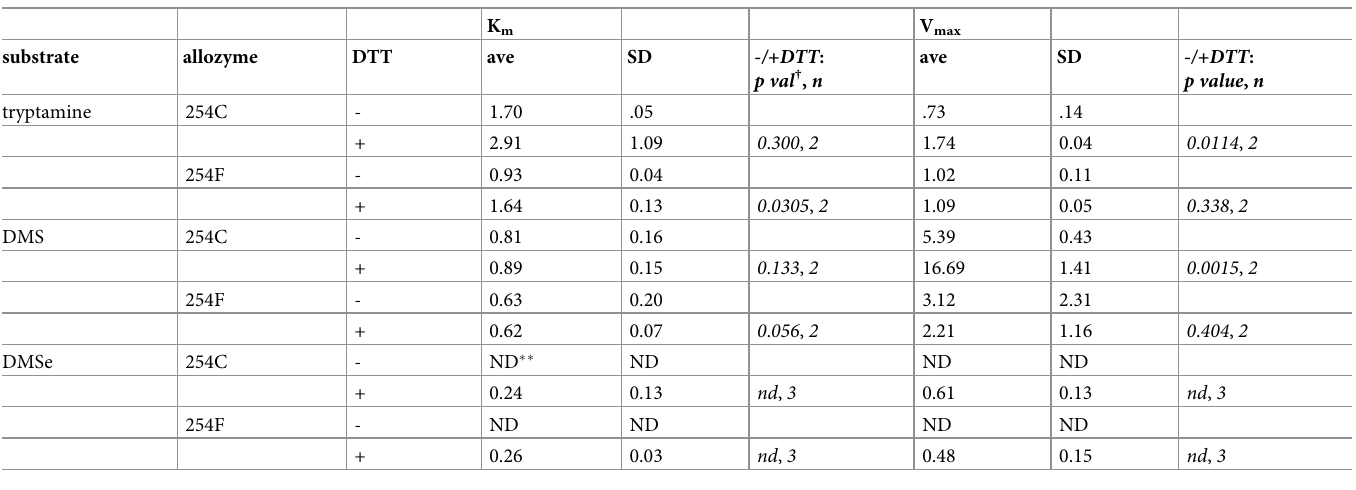
Fig 2. hINMT enzyme activity: 254C vs. 254F. Comparison of hINMT-catalyzed methylated product formation for 254C (A,C,E) and 254F (B, D, F) (-/+) 15 mM DTT for the substrates tryptamine (A, B), and DMS (C,D). The results for DMSe (E,F) are shown with (+) DTT only. Indicated concentrations of substrates were co-incubated with 5 μ g of 254C hINMT or 254F hINMT and 30 μ M 14- C S-adenosyl-methionine as described in Materials and Methods. Statistical analysis of results is described in Table